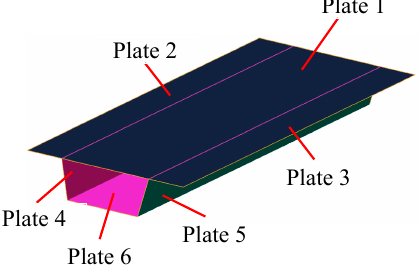
Figure 15. Panel area division of box girder.